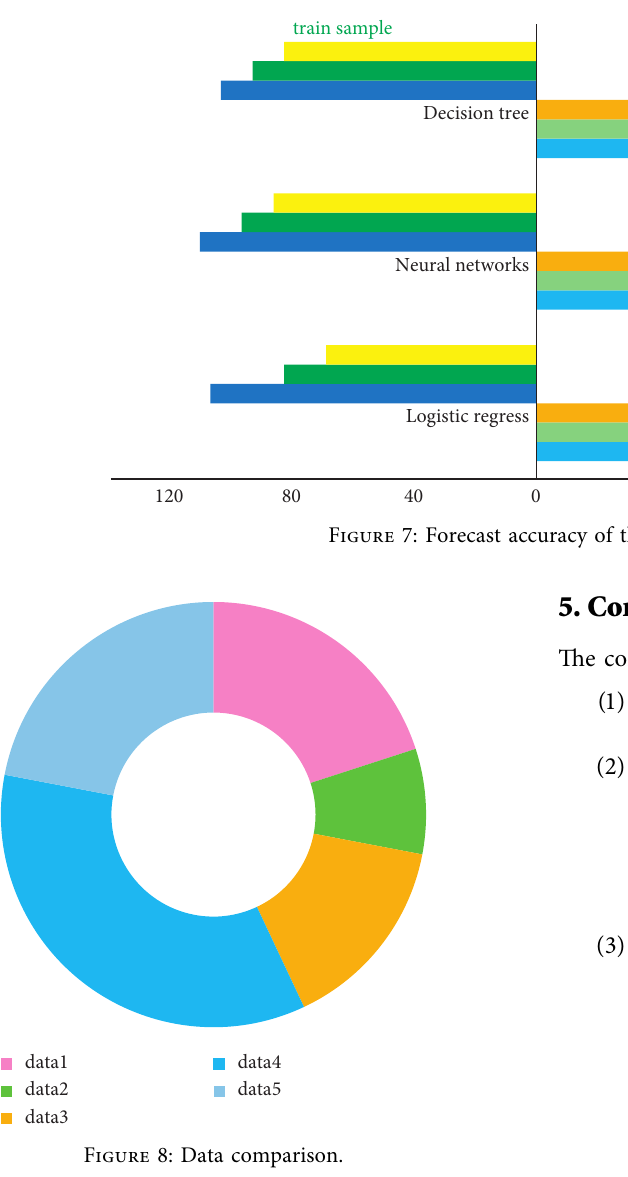
Figure 8: Data comparison.